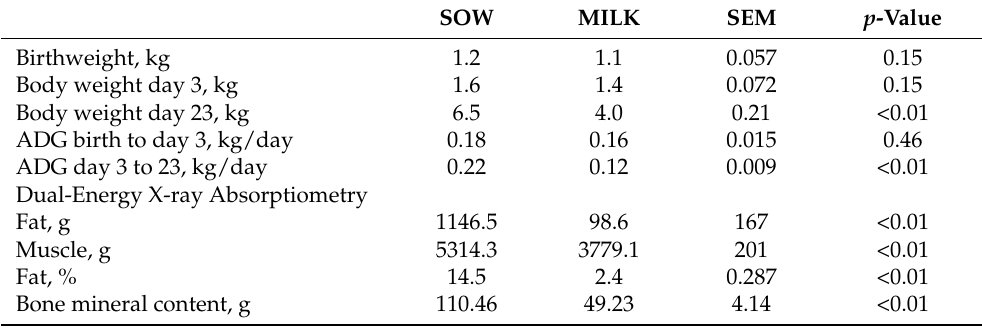
Table 3. Growth performance a body composition of sow (SOW) and artificial (MILK) reared piglets. SOW MILK Birthweight,